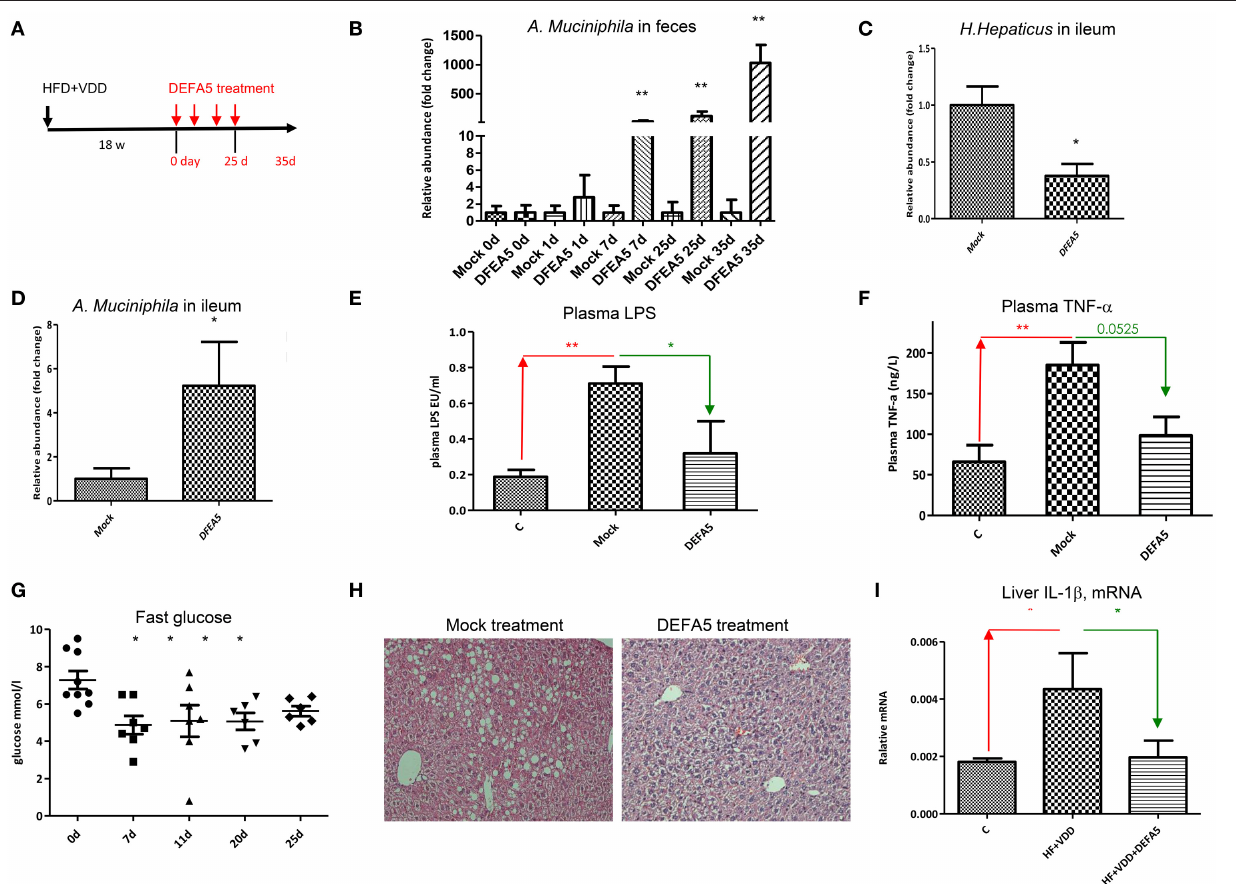
FIGURE 6 | Oral administration of human alpha-defensin 5 rebalances gut microbiota and resolves hepatic steatosis. (A) Experimental design. Balb/C mice were fed with HFD + VDD for 18w, followed by administrated synthetic human DEFA5 (10 µ g /dose or mock with saline) by oral gavage for 4 times within 25d, and the mice were terminated in additional 10 days ( n = 6 for each group). (B) Relative abundance of A. muciniphila presented in the feces during the treatments was quantitated by 16S rDNA qPCR analysis. Changing folds over the mock were plotted. (C) Relative abundance of H. hepaticus in the lumen of ileum after the treatment was quantitated by 16S rDNA qPCR analysis. (D) Relative abundance of A. muciniphila in the lumen of ileum after the treatment was quantitated by 16S rDNA qPCR analysis. (E) The plasma levels of endotoxin after the treatment were determined by Limulus Amebocyte Lysate test. (F) The plasma levels of TNF- α was